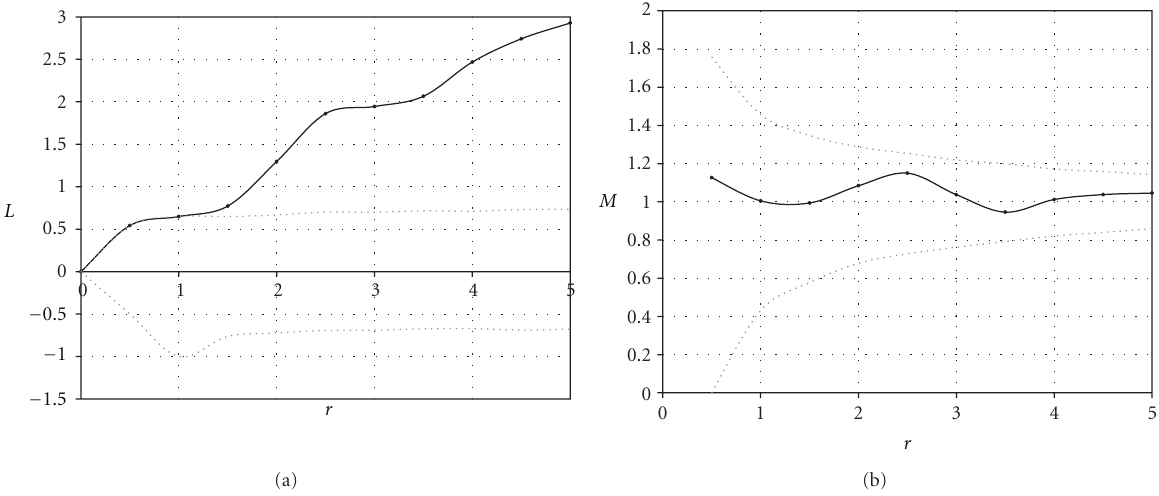
Figure 6: Inhomogeneous point set, univariate L and M functions for black points. L is not pertinent contrarily to M that controls for first-order